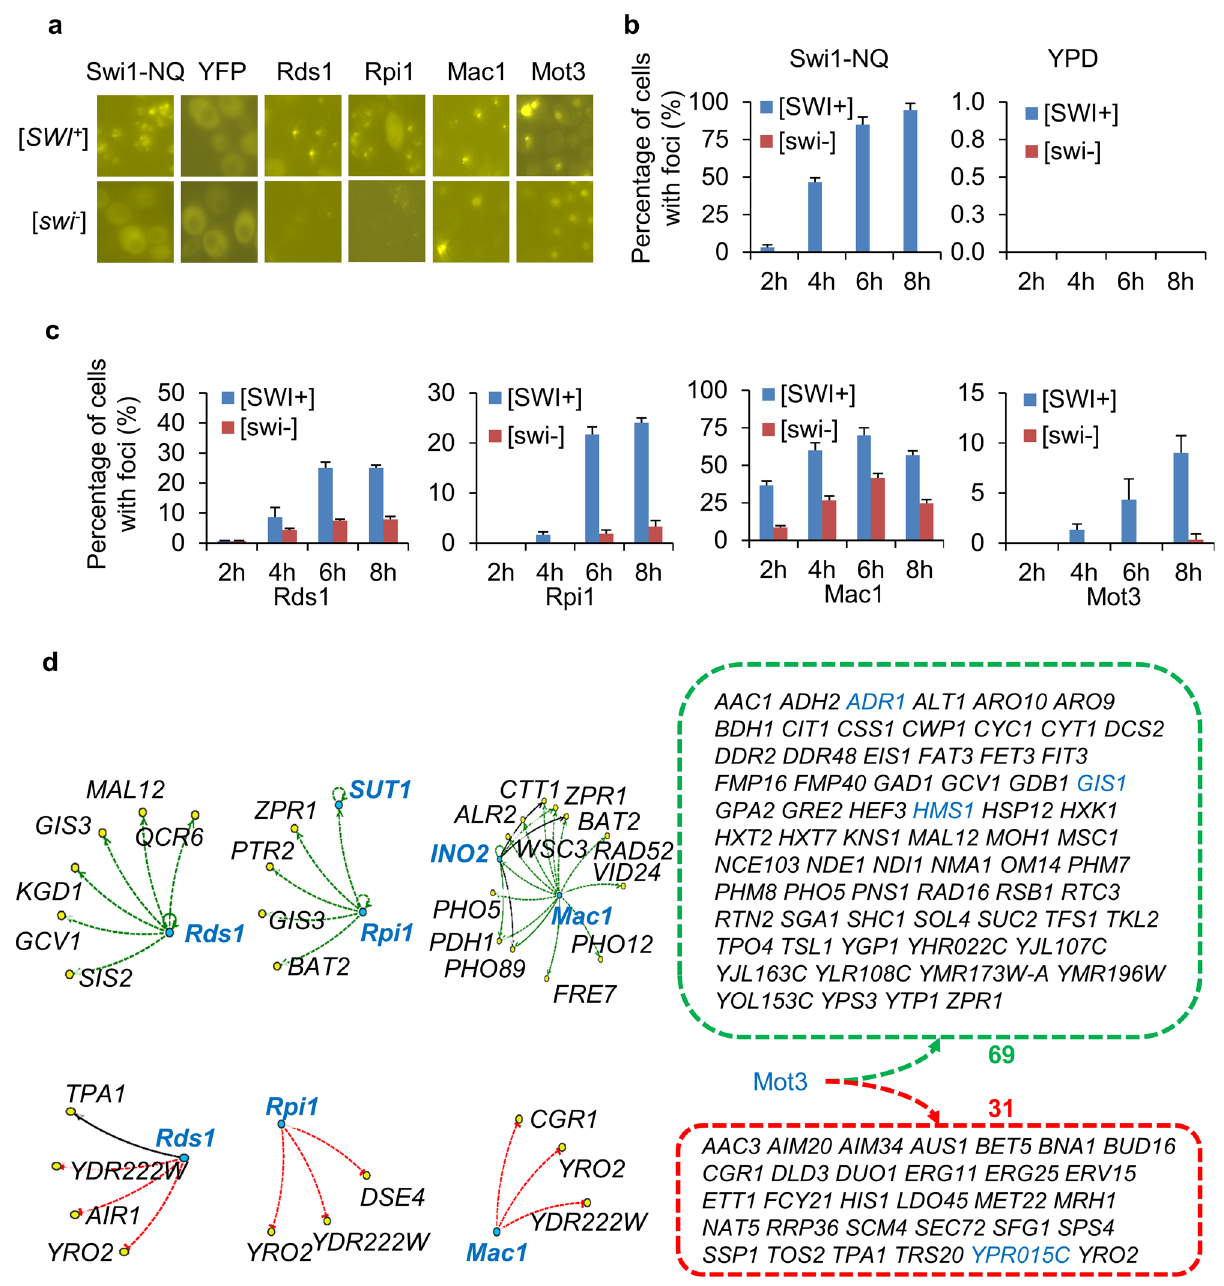
Figure 3. Contribution of higher aggregation propensities of 4 examined TFs to [ SWI + ] DEGs. ( a – c ) The 4 TFs are more aggregable in [ SWI + ] cells than in non-prion ([ swi − ]) cells among 30 tested TFs that were predicted having a higher aggregation propensity and with overrepresented targets in [ SWI + ]-DEGs (see Table S2 for details). To avoid unnecessary overproduction, 0.02% galactose was used to induce the expression of the indicated proteins from a single-copy plasmid. Representative images of the indicated YFP fusions are shown in panel ( a ), and quantitative results are shown in panel ( b ) (Swi1-NQ-YFP as positive control and YFP as negative control) and in ( c ) (for tested TFs). ( d ) Reduced activity of the 4 TFs due to aggregation explains the inhibition (upper) and activation (bottom) of [ SWI + ] DEG targets when they function as activators and inhibitors, respectively. All TFs in the regulatory network are highlighted by